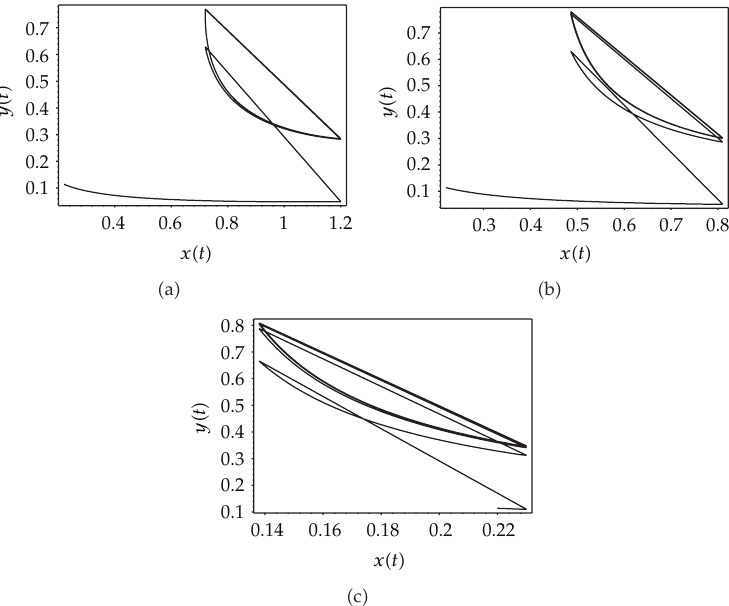
Figure 11: The phase portraits of system (cid:6) 1.3 (cid:7) with p (cid:8) 0 . 4, q (cid:8) 0 . 4, x 0 (cid:8) 0 . 22, y 0 (cid:8) 0 . 114, ι (cid:8) 0 . 6, and di ff erent h : (cid:6) a (cid:7) h (cid:8) 1 . 2; (cid:6) b (cid:7) h (cid:8) 0 . 81; (cid:6) c (cid:7) h (cid:8) 0 .